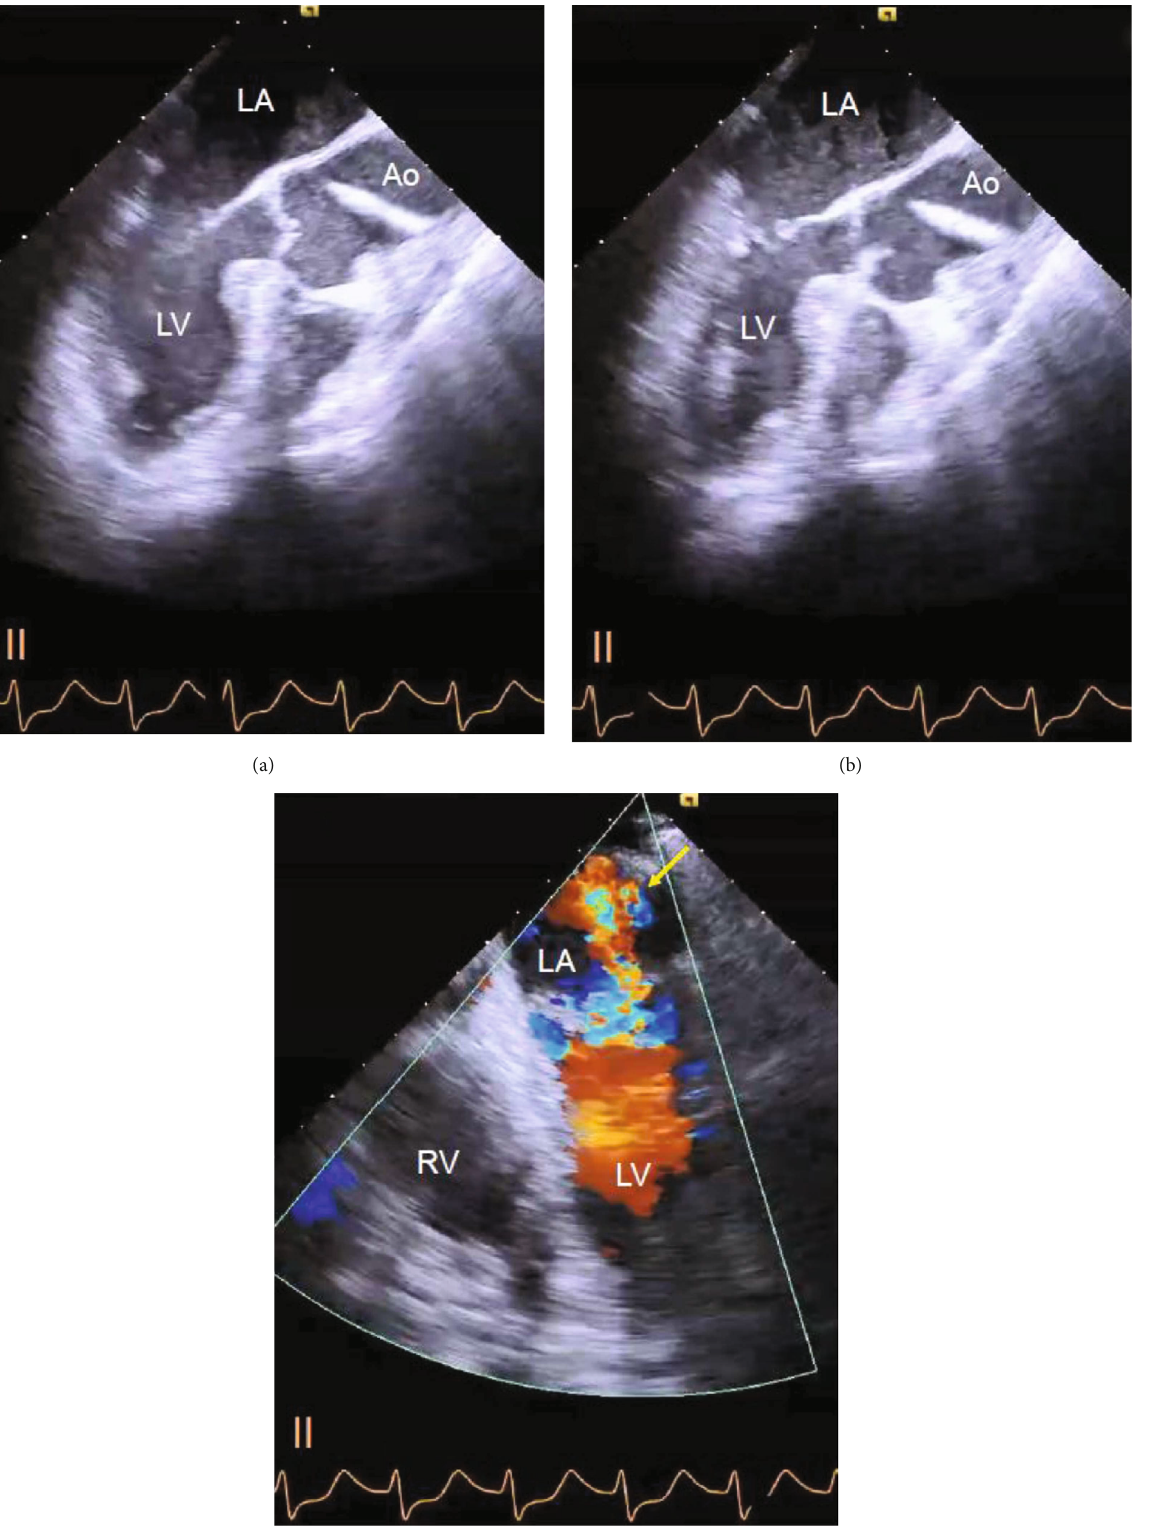
Figure 1: Transesophageal echocardiography. (a, b) Severe hypokinesis of the anteroseptal wall was observed at a 130 ° angle in a (diastole) and b (systole). Left ventricular ejection fraction was measured as 20%. LA: left atrium; LV: left ventricle; Ao: aorta; RV: right ventricle. (c) Severe mitral regurgitation at a 0 ° angle